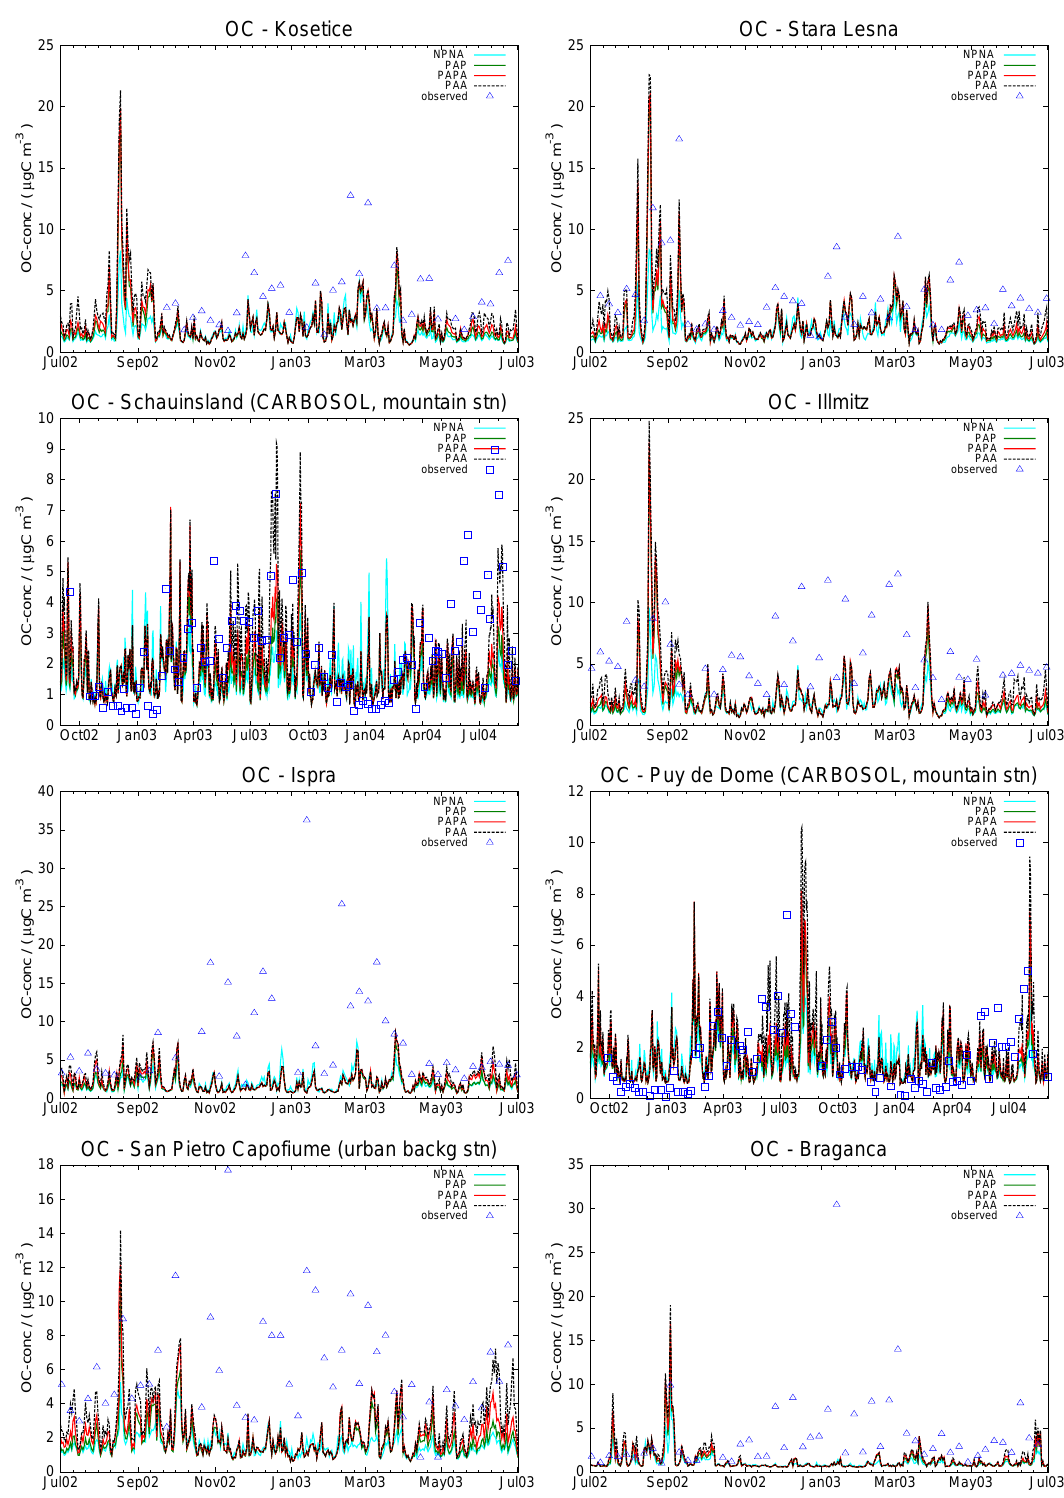
Fig. 9b. For Schauinsland and Puy de Dome observation data (indicated by squares) are weekly filter data from the CARBOSOL project, 2002–2004. Note that both these sites are mountain sites and often above the planetary boundary layer during